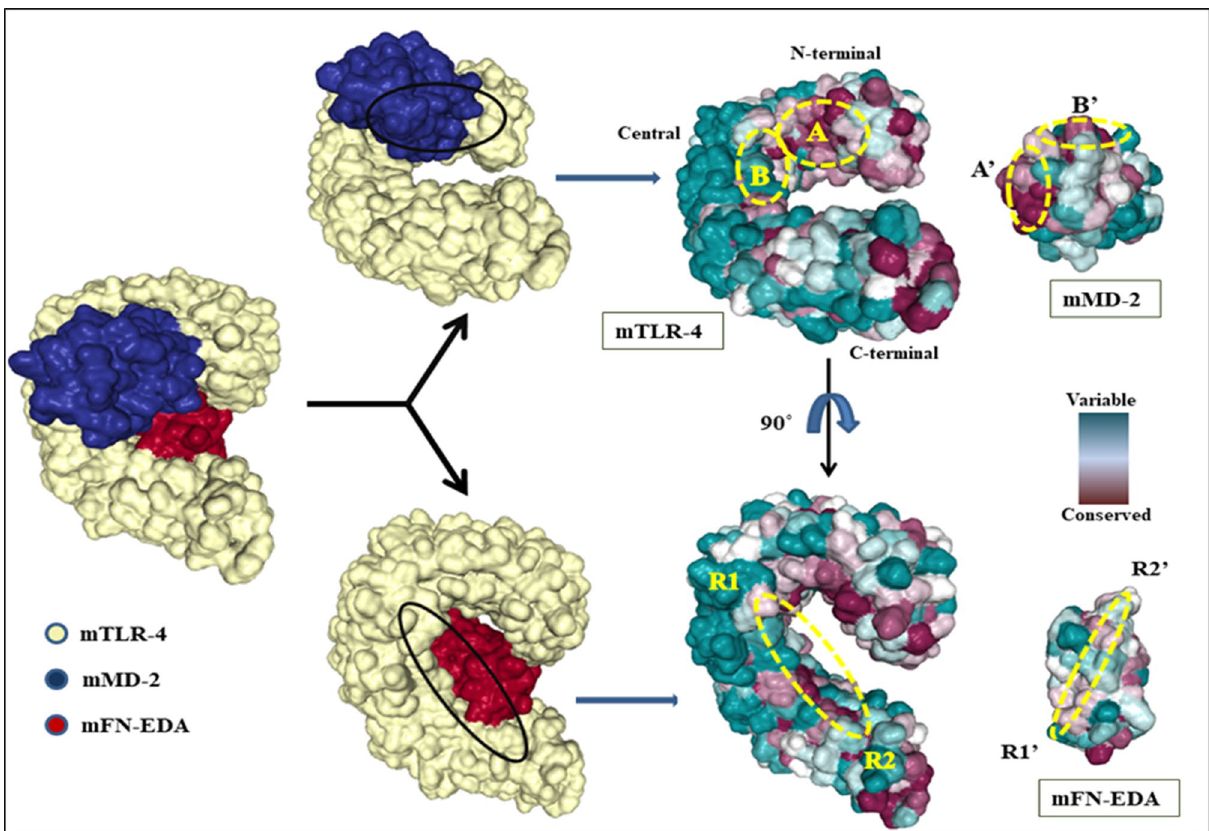
Figure 3. Representation of conserved regions in mouse TLR-4, MD-2 and FN-EDA according to the conservation scores obtained by the Bayesian method, using the ConSurf web server. Circular patches represent the interaction sites of MD-2 and FN-EDA with TLR-4 individually. Most of the residues in TLR-4, at the MD-2 interaction site, are strictly conserved, whereas most of the residues at the MD-2 interaction site are variable.